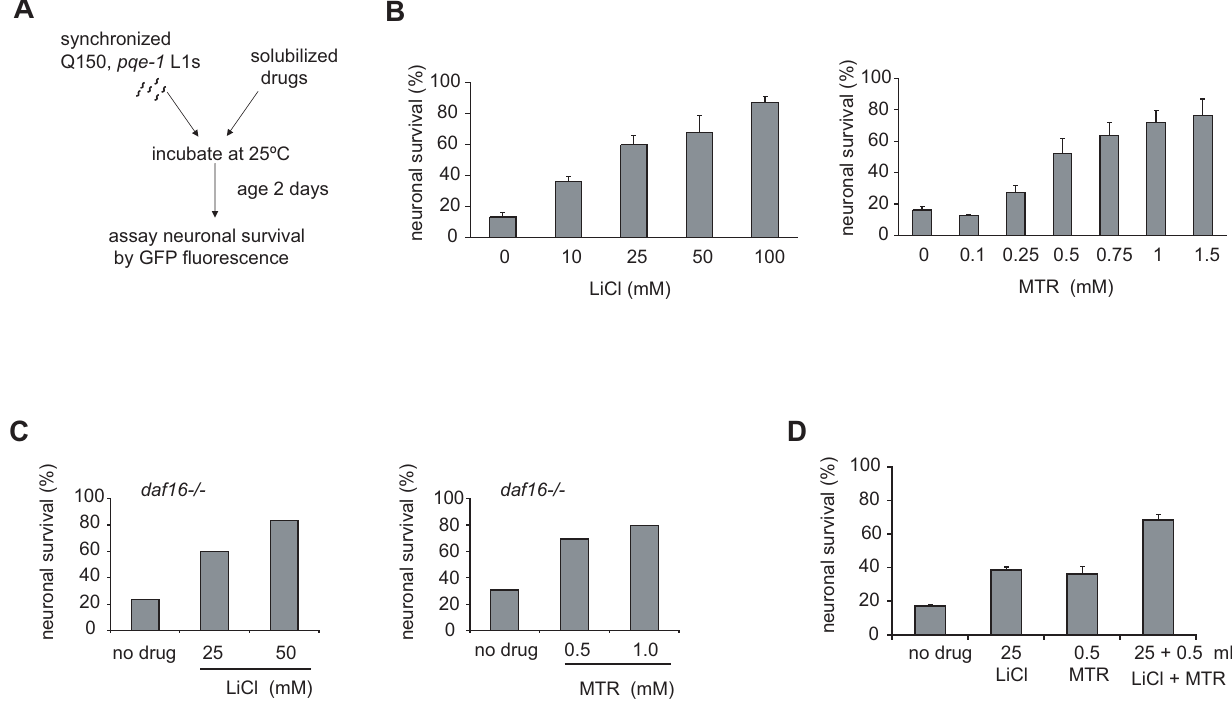
Figure 4. LiCl and MTR decrease polyQ toxicity measuring ASH neuronal death in the absence of growth. (A) Flow diagram of the starvation assay. 50 synchronized pqe-1;Htn-Q150 L1s per well were incubated at 25 u C in S medium with varying concentrations of compound to a total volume of 60 m l. On day 2, the survival of the ASH neuron was determined by visually evaluating the presence or absence of GFP expression. (B) LiCl and MTR increase neuronal survival in starved conditions. 100 neurons were scored for each trial; mean percentage of 3 different trials 6 SEM is shown. p=0.0063 for 10 mM LiCl; p , 0.0001 for 25 mM, 50 mM and 100 mM LiCl. p , 0.0001 for 0.5 mM, 0.75 mM, 1.0 mM, and 1.5 mM MTR. (C) LiCl and MTR increase neuronal survival in a daf-16 independent manner. At least 100 neurons were scored for each trial; percentage of neuronal survival in one representative experiment of 2 independent trials is shown; p , 0.0001 for 25 mM and 50 mM LiCl. p , 0.0001 for 0.5 mM and 1.0 mM MTR. (D) Combined, MTR (0.5 mM) and LiCl (25 mM) were more effective than either drug alone in protecting ASH neurons from polyQ neurotoxicity. 50 synchronized pqe-1;Htn-Q150 L1s per well were incubated at 25 u C in S medium with 0.5 mM MTR and 25 mM LiCl to a total volume of 60 m l. On day 2, the survival of the ASH neuron was evaluated by the presence or absence of GFP. 100 neurons were scored for each trial; mean percentage of 3 different trials 6 SEM is shown. The excess synergy was 0.14 based on a Bliss Independence analysis. p=0.046 for 0.5 mM MTR; p=0.0039 for 25 mM LiCl; p , 0.0001 for LiCl +